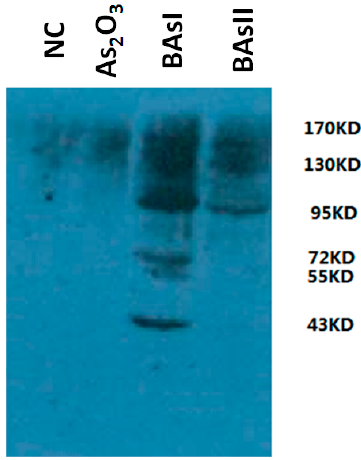
Figure 2. Detection of arsenic-biotin conjugating proteins in NB4 cells. NC (negative control).